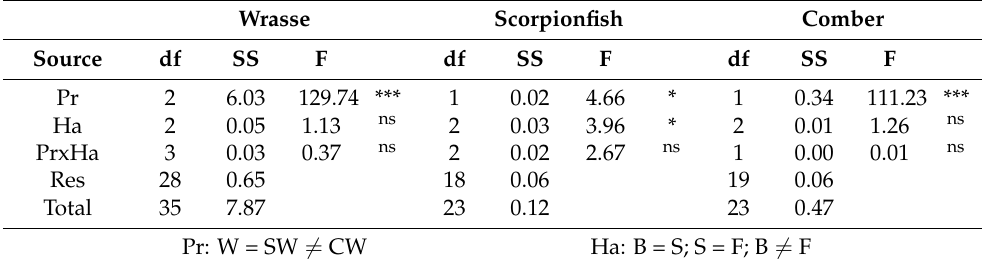
Pr: W = SW (cid:54) = CW Ha: B = S; S = F; B (cid:54) =